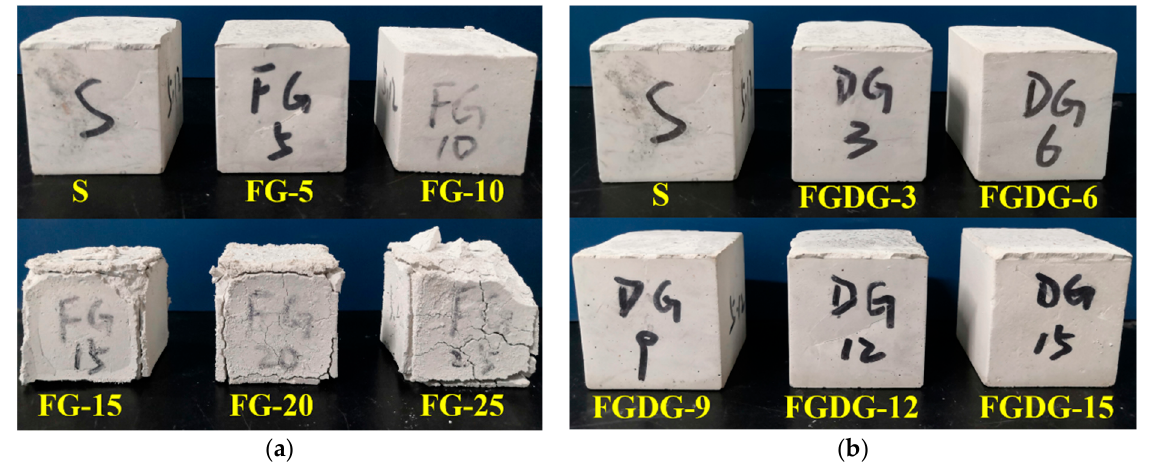
Figure 5. Effect of two types of gypsum on mass change results: ( a ) FG; ( b ) FGDG.